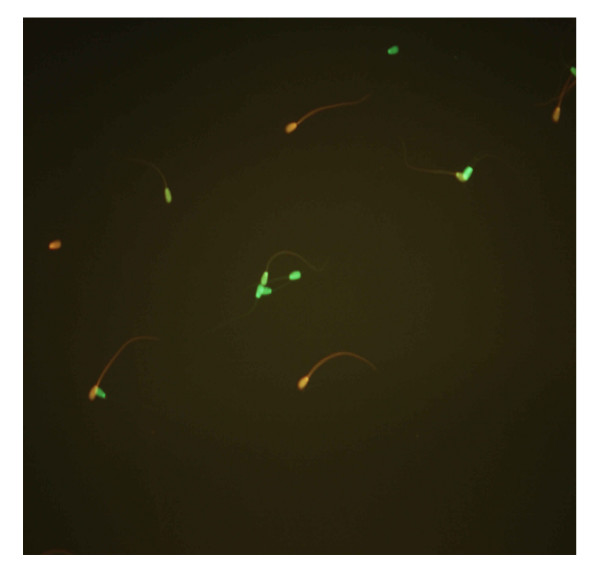
Live (green) and dead (red) sperms after SYBR-14/PI test (400×).